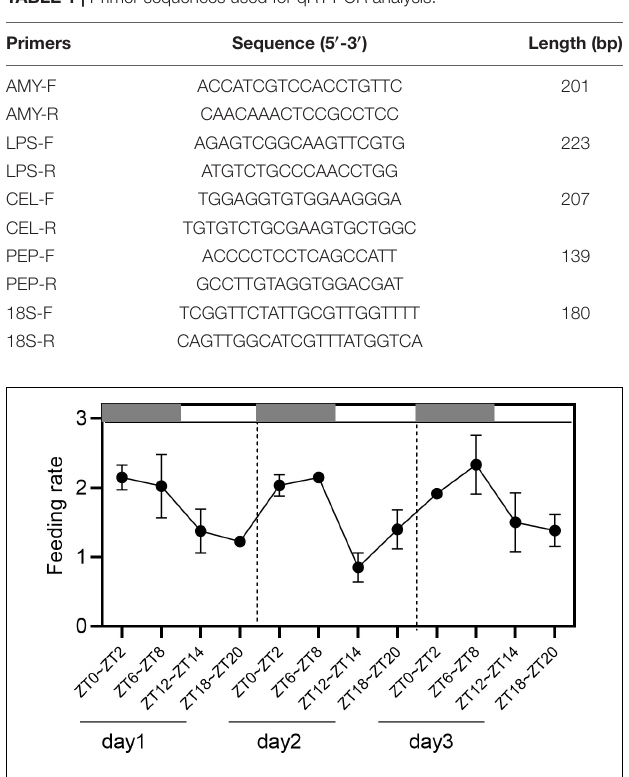
TABLE 1 | Primer sequences used for qRT-PCR analysis.